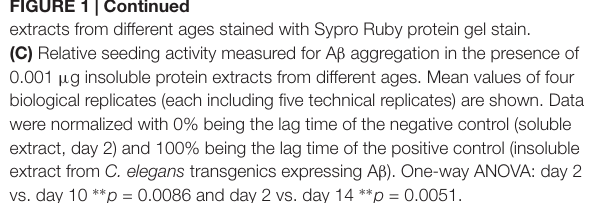
FIGURE 1 | Continued extracts from different ages stained with Sypro Ruby protein gel stain. (C) Relative seeding activity measured for A β aggregation in the presence of 0.001 µ g insoluble protein extracts from different ages. Mean values of four biological replicates (each including five technical replicates) are shown. Data were normalized with 0% being the lag time of the negative control (soluble extract, day 2) and 100% being the lag time of the positive control (insoluble extract from C. elegans transgenics expressing A β ). One-way ANOVA: day 2 vs. day 10 ∗∗ p = 0.0086 and day 2 vs. day 14 ∗∗ p =